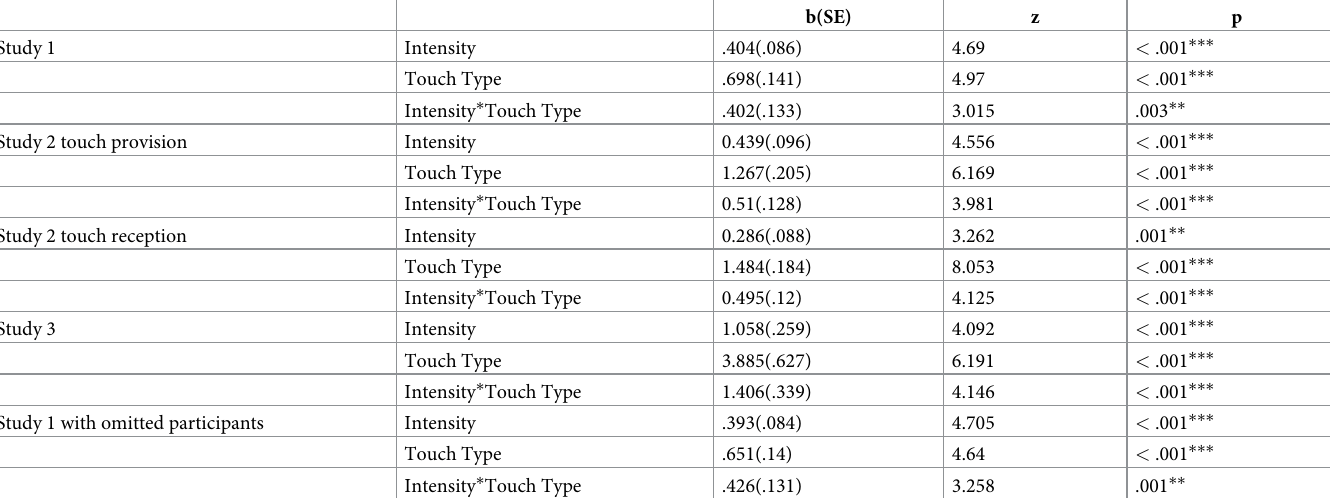
Table 1. The effect of intensity measured by intensity ratings and touch type on touch preference analyzed using cumulative link models.